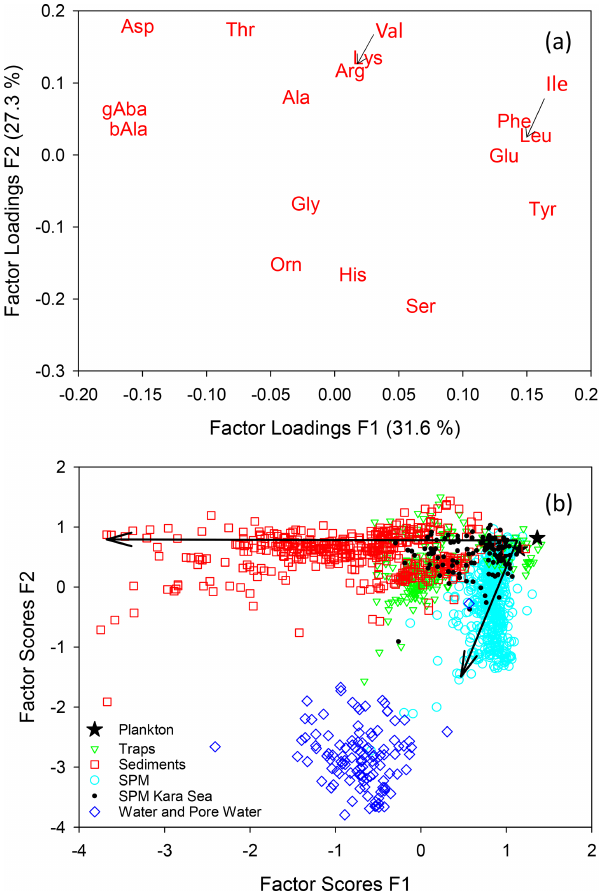
Figure 6. Results of a PCA of AAs (Mol%) of all samples of this study with factor loadings of amino acids for the first and second factors (a) and factor scores of samples (b) . Small arrows in (a) point to the positions of Val and Ile. Arrows in (b) indicate progres- sive deviation in composition from the plankton source, essentially with increasing water and sediment